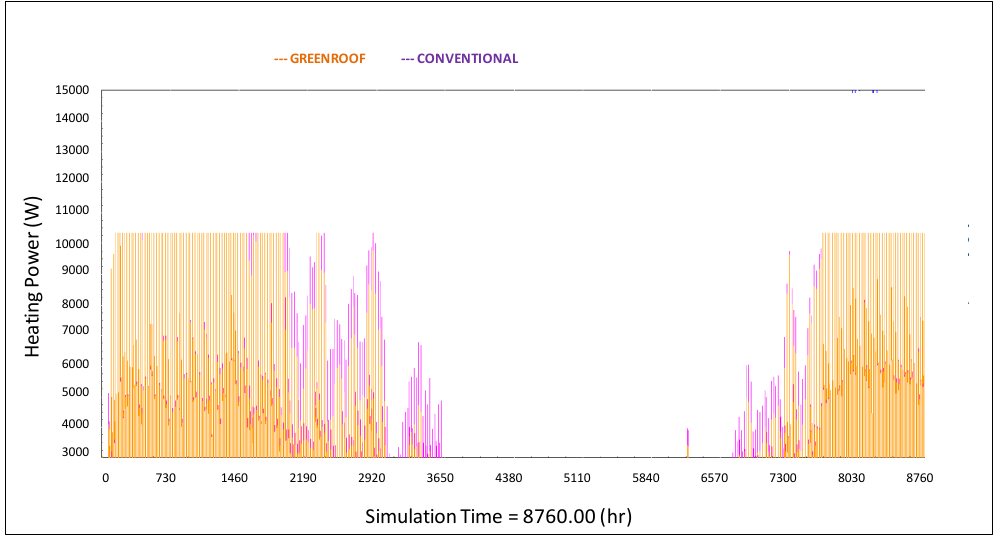
Figure 17. Results of the heating demand in both rooftops.